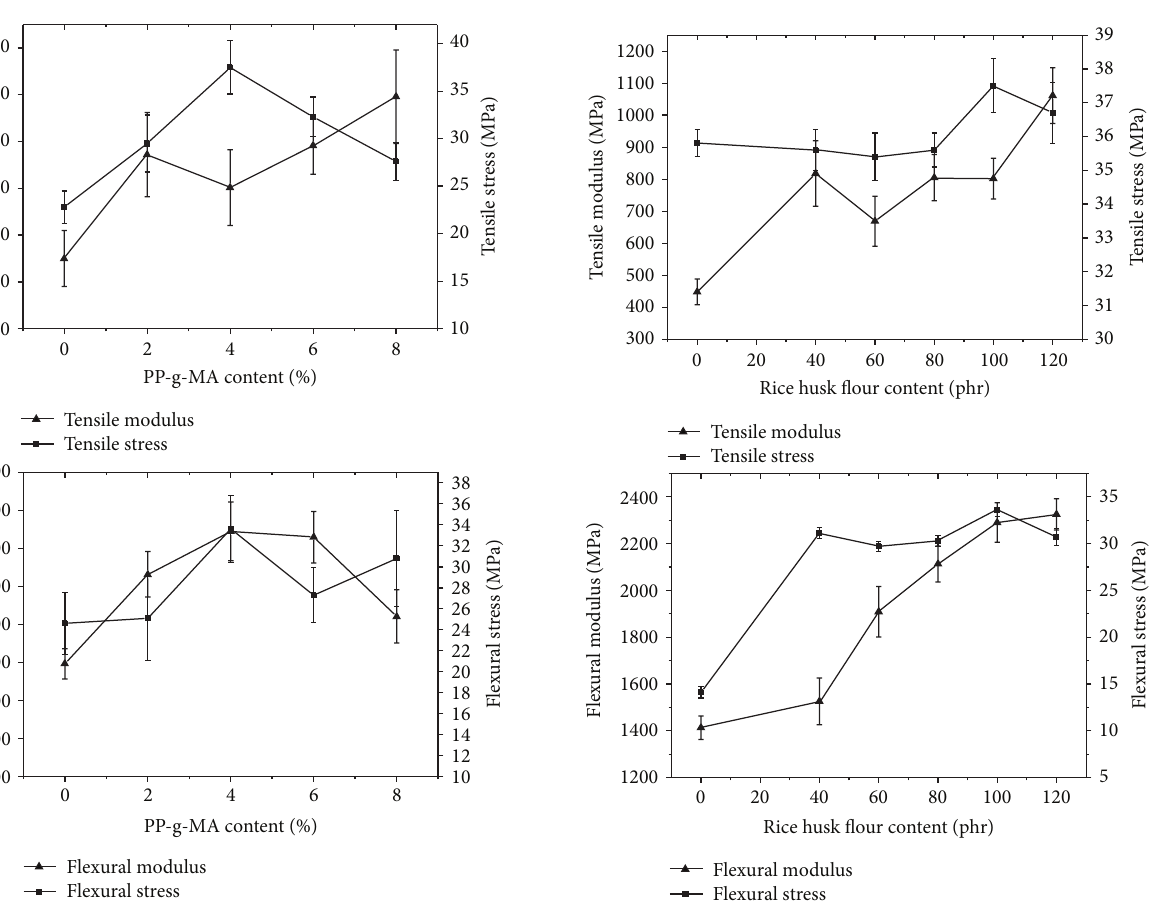
Figure 6: Effect of RHF content on tensile and flexural strength of PP/RHF composites in the presence of 4wt% PP-g-MA.